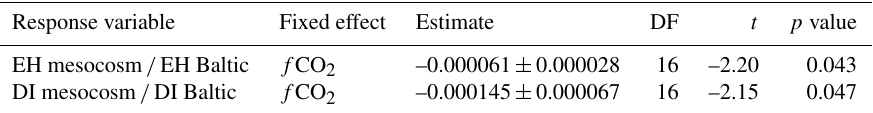
Table 5. T statistics of the retained fixed effects in the LMMs testing the effect of f CO 2 , TPC (<55µm) and C:N on ratio of EH meso- cosm / EH Baltic and nauplii development index (DI) mesocosm / DI Baltic. Ratio>1: higher EH or DI in the mesocosm water (maternal environment) than in the Baltic Sea water, ratio<1: lower EH or DI in the mesocosm water (maternal environment) than in the Baltic Sea water. Repeated measures of same mesocosm bags were used as a random effect in both models, because copepods that come from the same bags are more alike than copepods from different